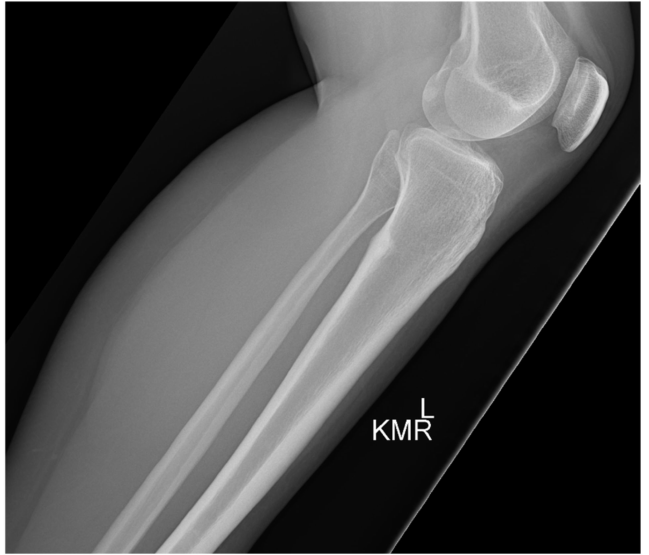
Figure 3. Pre-treatment lateral X-ray of the left leg demonstrating a sclerotic cortically based lesion in the proximal posterior